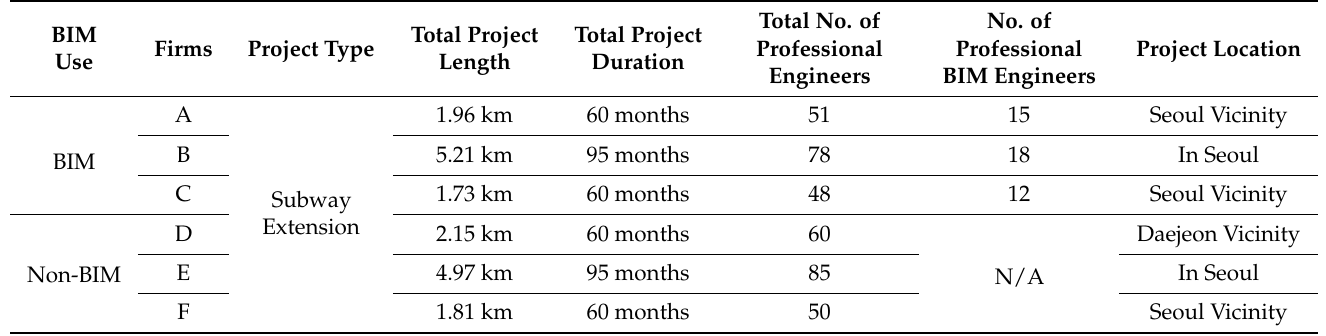
Table 1. Basic information about the 6 selected firms and